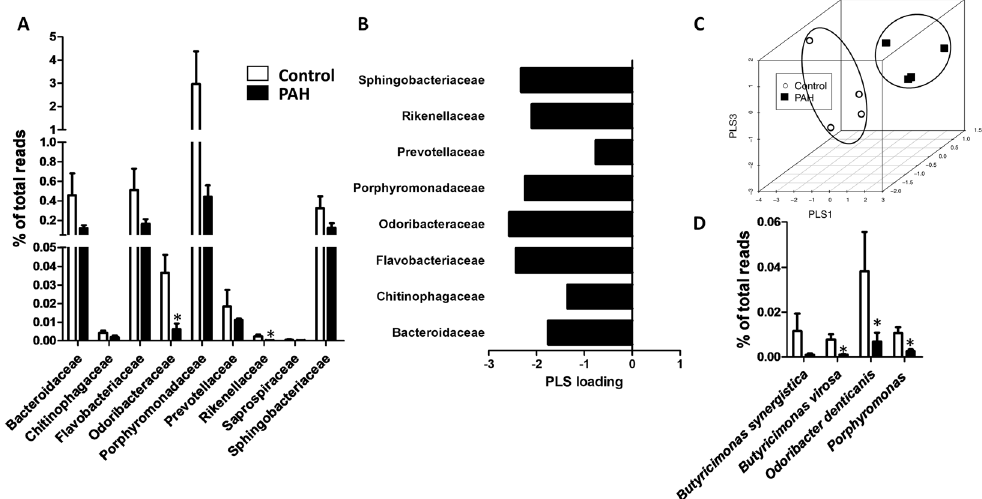
Figure 5. Bacterial families within the Bacteroidetes phylum. ( A ) Composition of the bacterial families expressed as a percent of total bacteria in control and PAH rats (means ± s.e.m. of 4 animals, * p < 0.05 vs control with student’s t-test) ( B ) PLS loadings (data shown for phyla representing > 0.1% of total bacteria) highlight variable significance to discriminate between PAH and control samples in PLS scores. ( C ) Tridimensional PLS scores plot. ( D ) Composition of the species within the Odoribacteraceae family and Porphyromonas (means ± s.e.m. of 4 animals, * p < 0.05 vs control with student’s t-test).